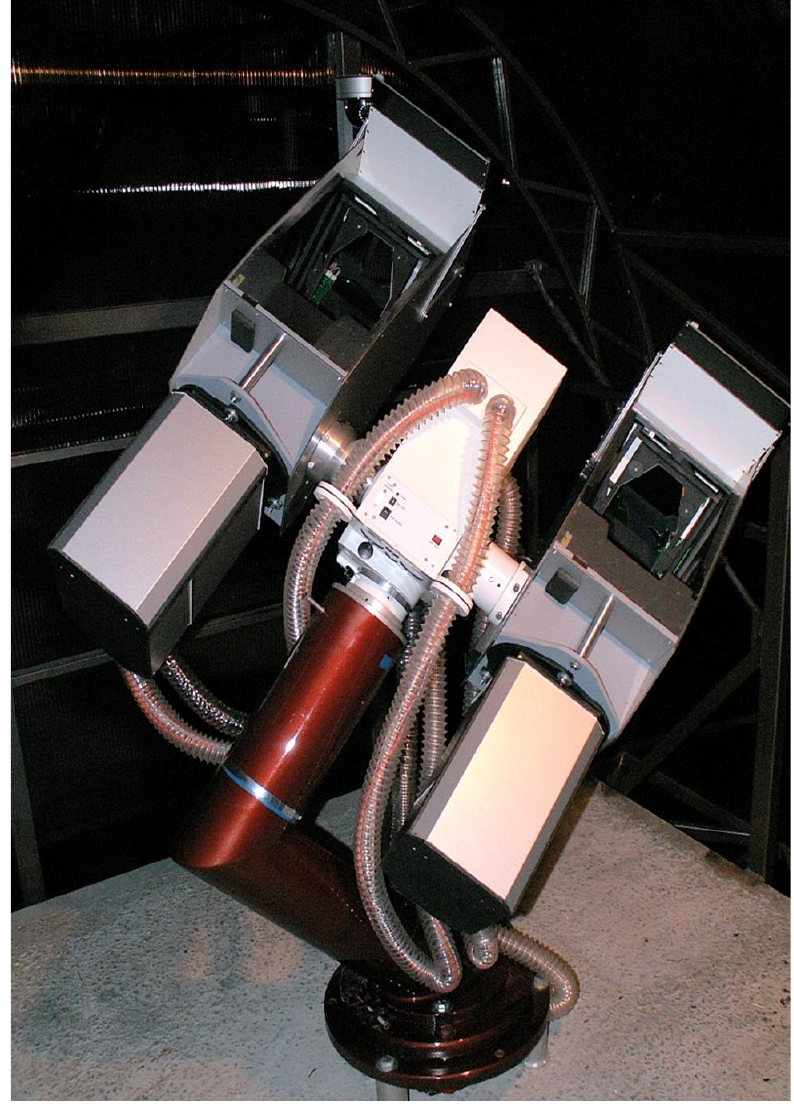
Figure 1. General view of the mount with two